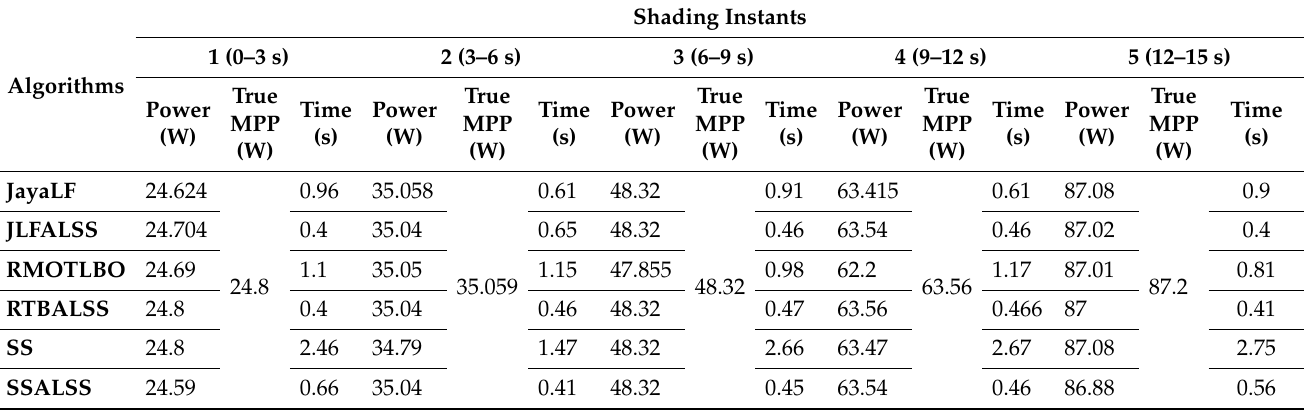
Table 6. Performance summary of the “increasing-insolation” dynamic PS scenario.